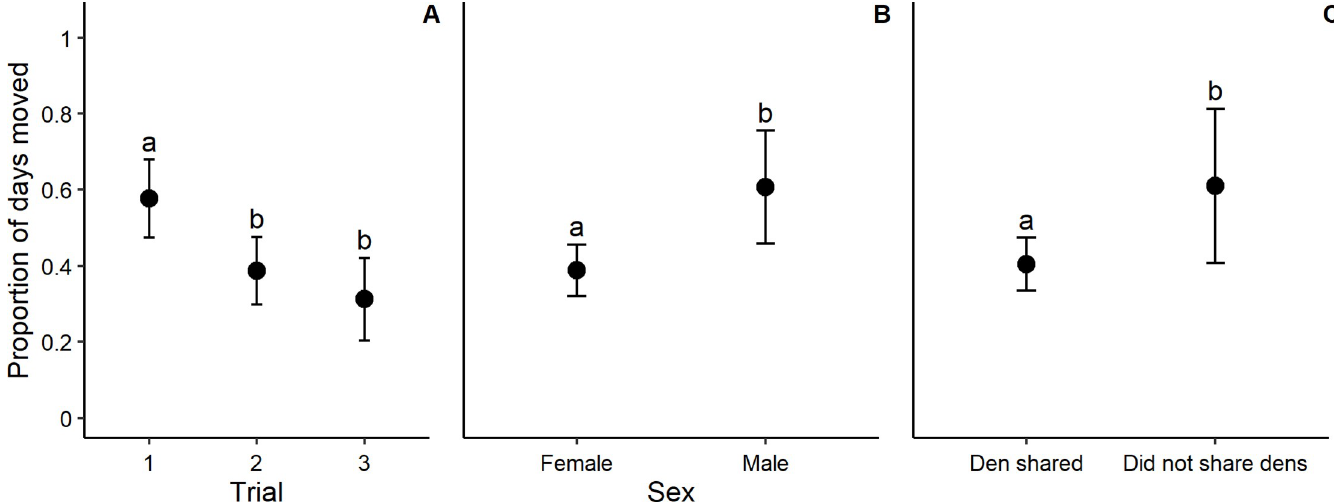
Fig 3. Proportion of days moved between dens for eastern quoll ( Dasyurus viverrinus ) founders translocated to Mulligans Flat Woodland Sanctuary, ACT Australia. Proportion of days moved presented by trial (3A, Trial 1 n = 9, Trial 2 n = 12, Trial 3 n = 8), sex (3B, female n = 24, male n = 5) and whether a founder den shared with another founder (3C). Error bars represent 95% confidence intervals for predicted values, and letters indicate significant differences (where p < 0.05).